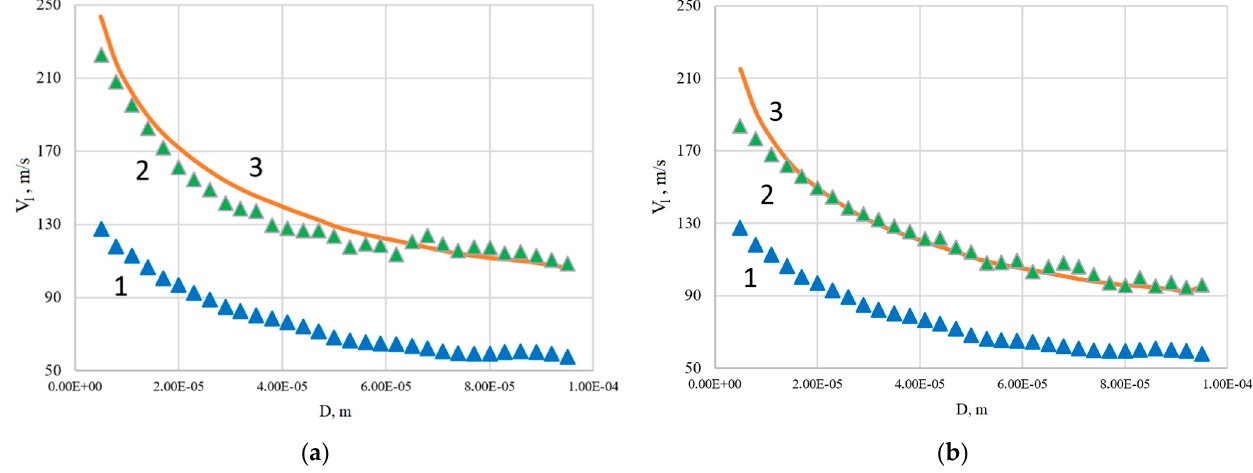
Figure 7. The example of the distribution of droplet velocities without shock wave ( a ) and with shock wave ( b ): 1—experimental distribution in area 1; 2—experimental distribution in area 2; 3—calculated distribution in area 2.